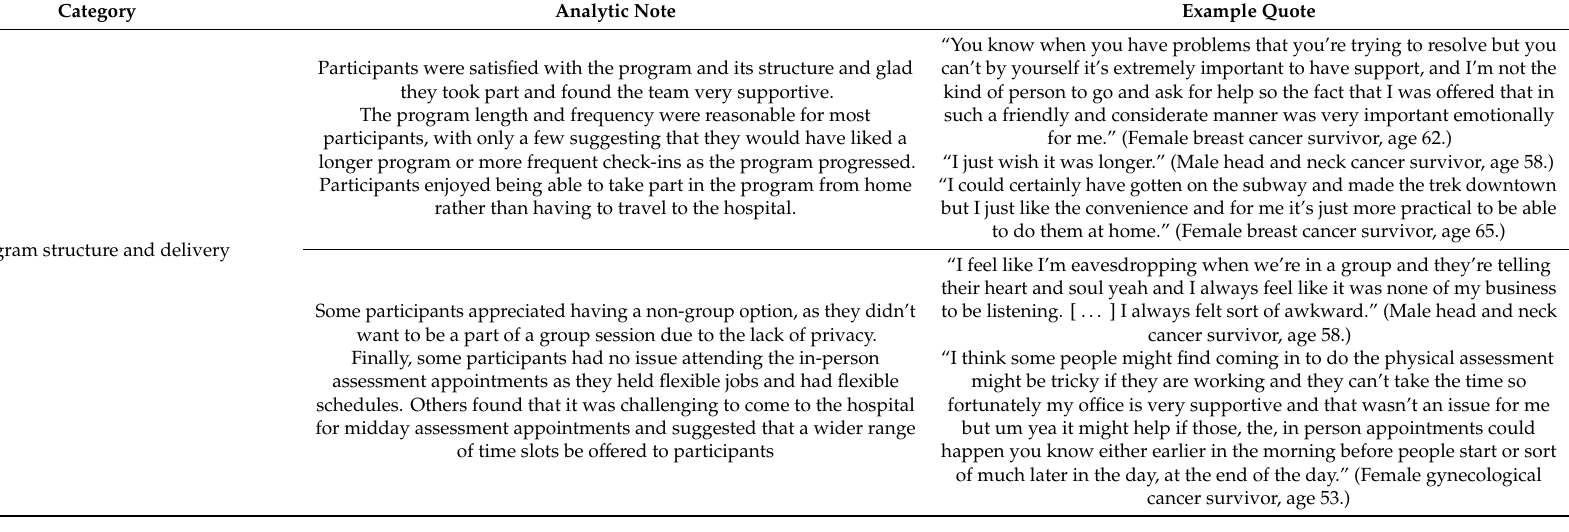
Table 3. Qualitative Table for